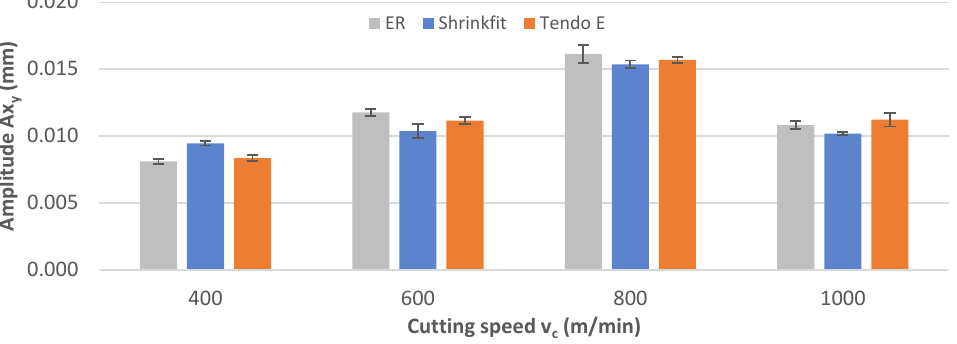
Figure 7. Impact of cutting speed v c on the vibration displacement amplitude Ax y (f z = 0.15 mm/tooth, a p = 6 mm). The impact of the cutting speed change on rms displacement values x y_RMS is shown in Figure 8. The cutting speed increase resulted in a gradual value increase up to the speed of v c = 800 m/min, followed by a slight decrease. The achieved rms values were 0.005 – 0.014 mm, with the lowest values for the hydraulic chuck while machining at a speed of v c = 400 m/min, the heat shrink chuck at v c = 600 m/min, and the ER collet chuck at v c = 800 – 1000 m/min.